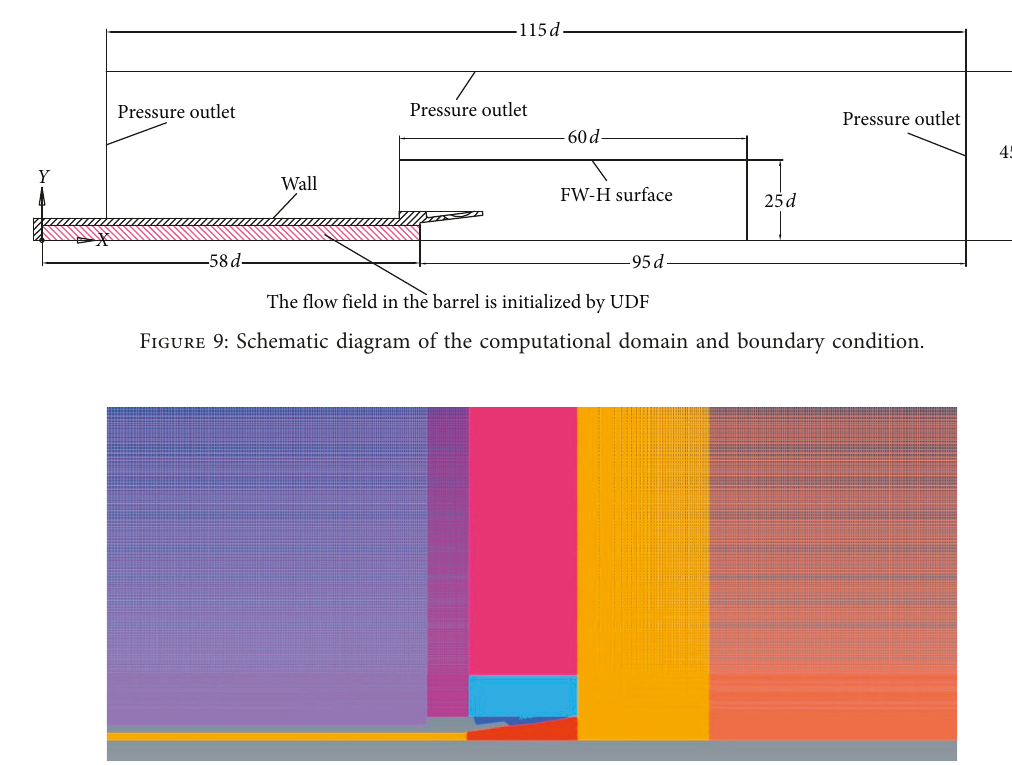
Figure 10: Grid model of the computational domain.